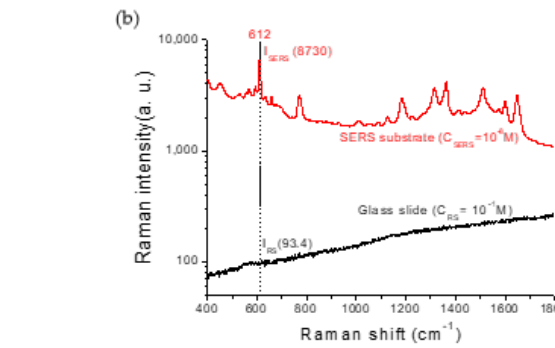
Sample (b) Figure 8. ( a ) The background-subtracted SERS spectra and ( b ) their integrated intensities of the 10 −6 M R6G analyte on different thicknesses of the Ag-deposited substrate. To this end, the integrated area of the background-subtracted SERS spectra was con- ducted by referring to the layer thickness as summarized in Figure 8b. The integrated in- tensity increased with the layer’s thickness until 6 nm (Sample C), then profoundly de- creased at 7.6 nm (Sample D), and fell to the lowest intensity of 12.1 nm (Sample F). Hence, even though the S/B ratio from Sample A was larger than Sample C , as listed in Table 6, Sample C presented the optimal SERS enhancement due to the highest integrated inten- sity of the SERS spectrum. In Figure 9a, the various R6G of concentrations from 10 −5 to 10 −1 0 M were used to determine the sensitivity of Sample C, in which the limit of detection (LOD) was 10 −8 M and the analytical enhancement factor (AEF) was 9.35 × 10 8 , as evaluated at 612 cm −1 by